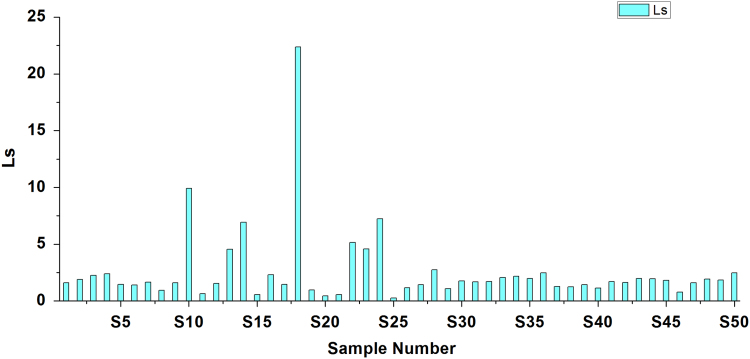
Learson–Skold index.